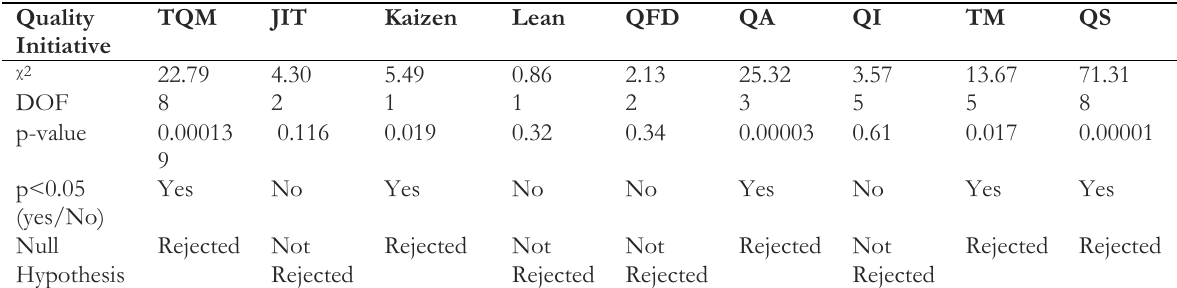
Table 4. Hypothesis testing for quality